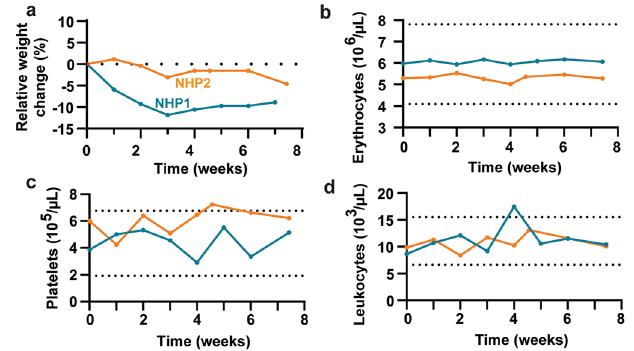
Figure 2. Health status of NHPs after dcl-NAC engraftment. ( a ) Weekly percent change in weight relative to weight at week 0. ( b – d ) Weekly erythrocyte, platelet, and leukocyte cell counts. Horizontal dashed lines represent normal range boundaries; blue, NHP1; orange,